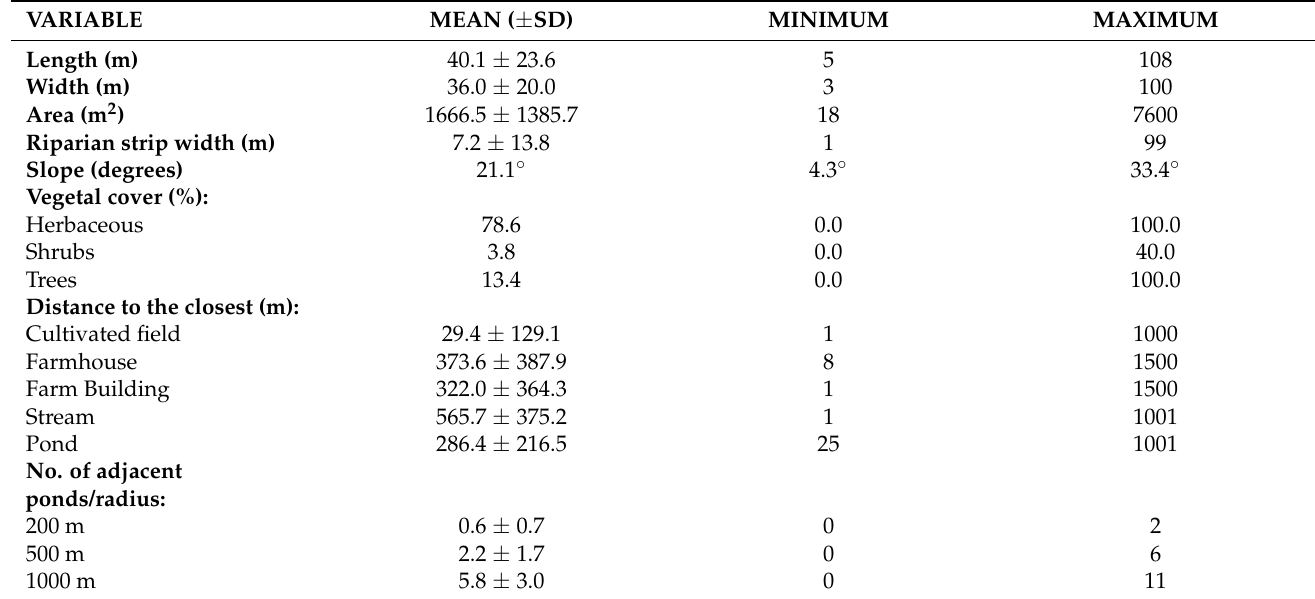
Table 1. Biophysical characteristics of the 61 farm ponds studied in the Boyer River watershed, St. Lawrence Valley lowlands, Southern Quebec (Canada). Sample size differs for the following variable: the estimated area ( n =